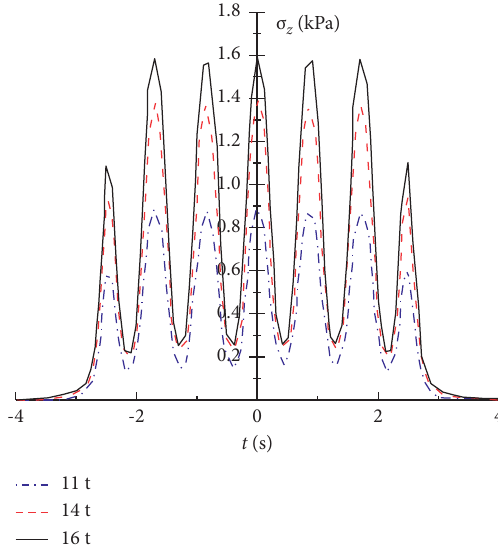
Figure 7: σ z (o)f soil with different axes.